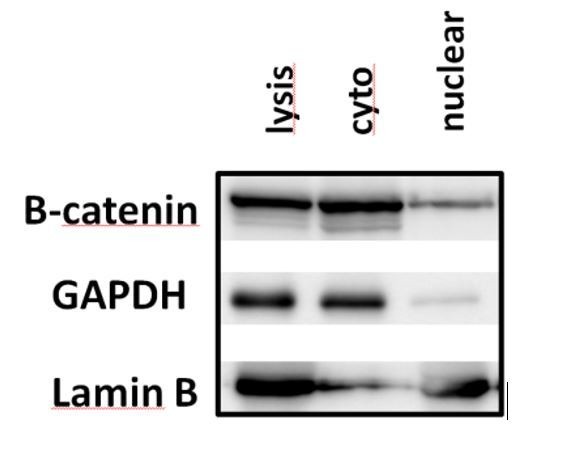
The expression of β-catenin in the cytoplasma and nucleus.